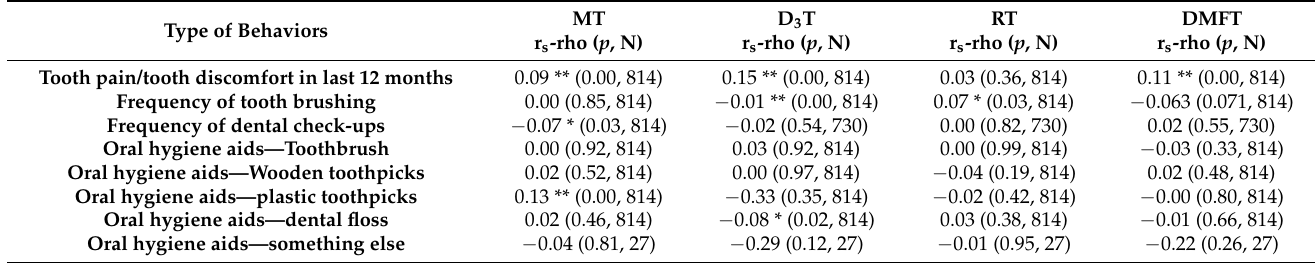
Table 5. Correlation between different types of preventive behaviors and MT, D 3 T, RT, and DMFT indices. Type of Behaviors Tooth pain/tooth discomfort in last 12 months